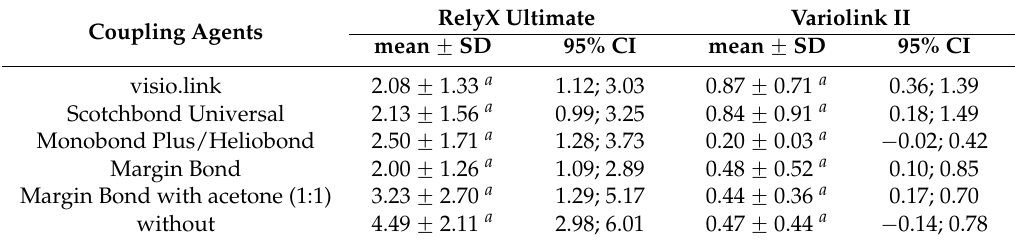
Table 2. Mean retention strength, standard deviation, and 95% confidence intervals of the resin cements on differently pretreated CAD/CAM resin surfaces and one-way ANOVA followed by Scheffé post-hoc between the coupling agents within one resin composite cement. All values are given in MPa. Differing lower case letters indicate significant differences between coupling agents.